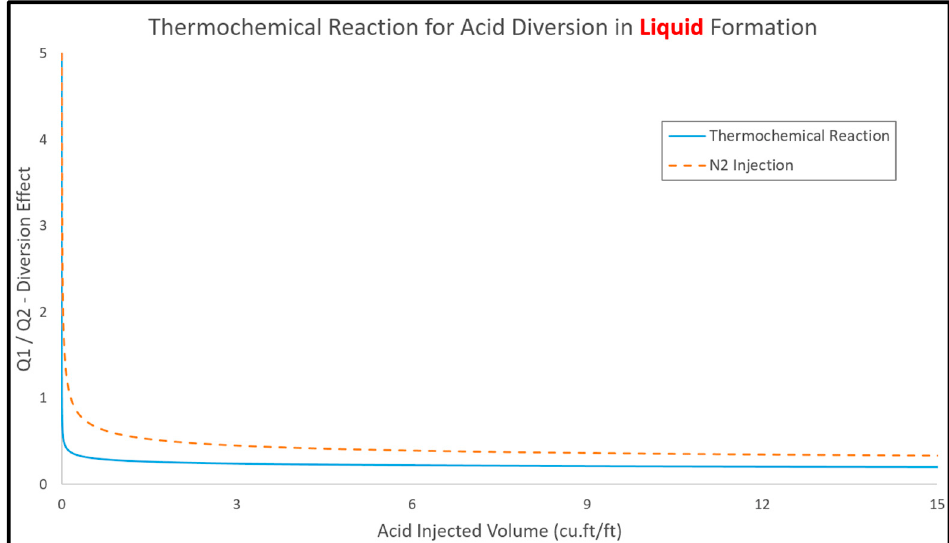
Figure 12. The injection rate ratio between top (Q1) and bottom (Q2) layer using thermochemical reaction and N 2 injection.